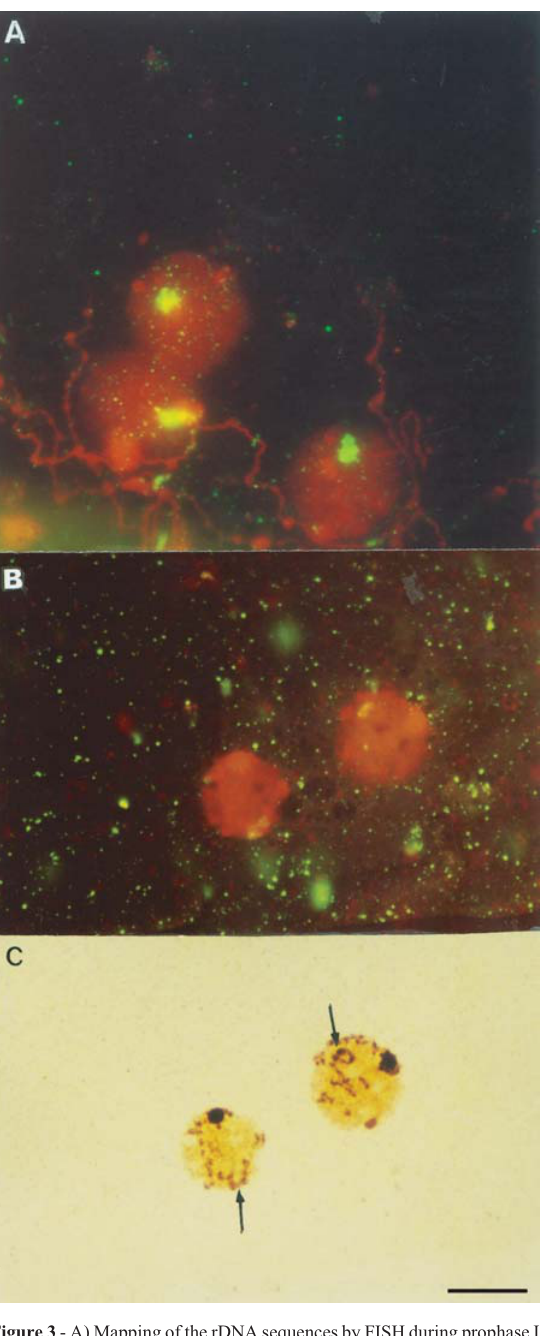
Figure3 -A)MappingoftherDNAsequencesbyFISHduringprophaseI (early zygotene). B) and C) Sequential FISH/Ag-NOR staining. Arrows show the location of the rDNA sequences outside the sex vesicle. Bar = 5 µ